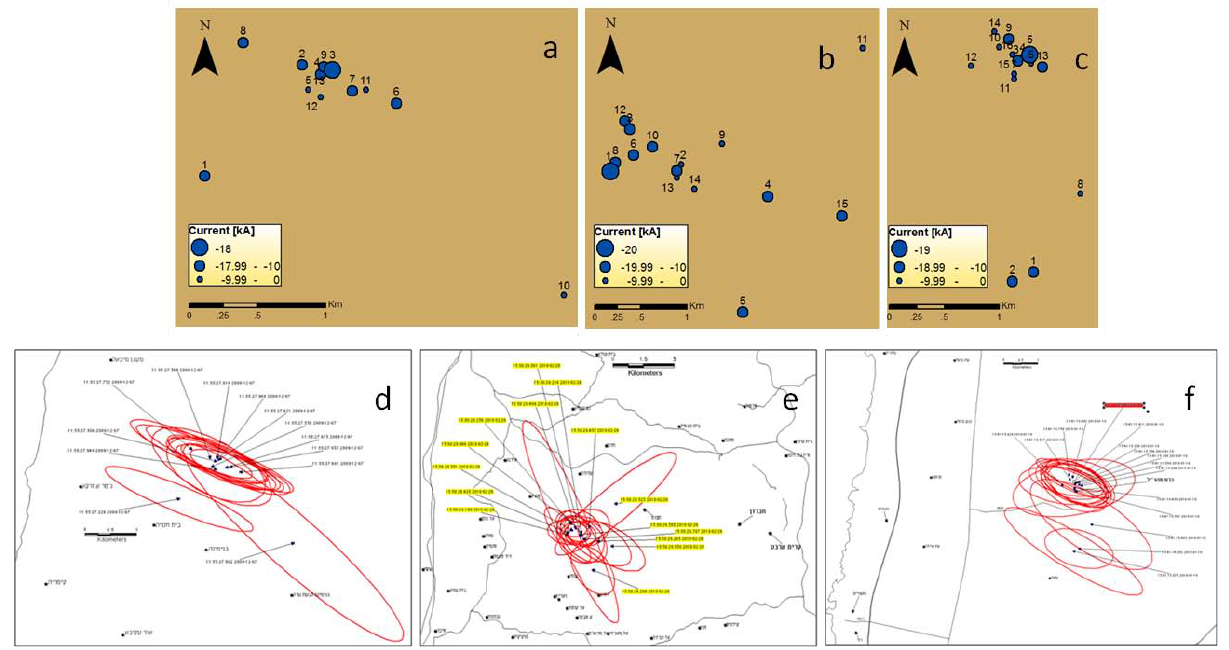
Fig. 5. Spatial distribution of successive strokes in 3 different lightning events with high multiplicity values, with the respective error ellipses. (a) Event E3, 7.12.2009, 11:55GMT, m = 13. (b) Event E2, 26.2.2010, 15:50GMT, m = 15. (c) Event E1, 18.1.2010, 13:41GMT, m = 16. (d) , (e) , (f) the respective error ellipses for the three